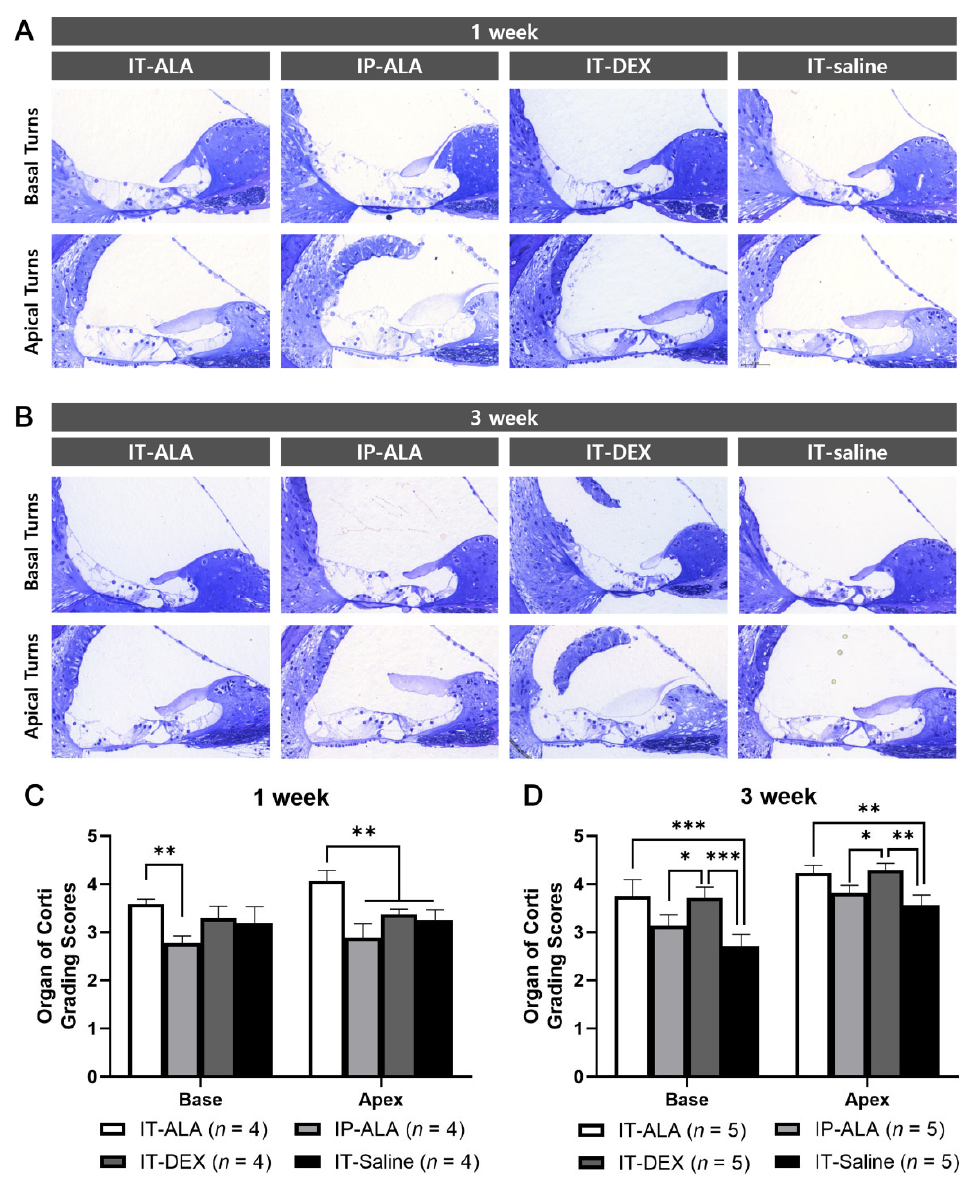
Figure 4. Morphological analysis of the OC in the mouse model of NIHL. Representative light microscopic findings at 1 week ( A ) and 3 weeks ( B ) after noise exposure. ( C ) OC grading scores were significantly higher in the IT-ALA group in the first week ( p < 0.01). ( D ). IT-ALA and IT-DEX were